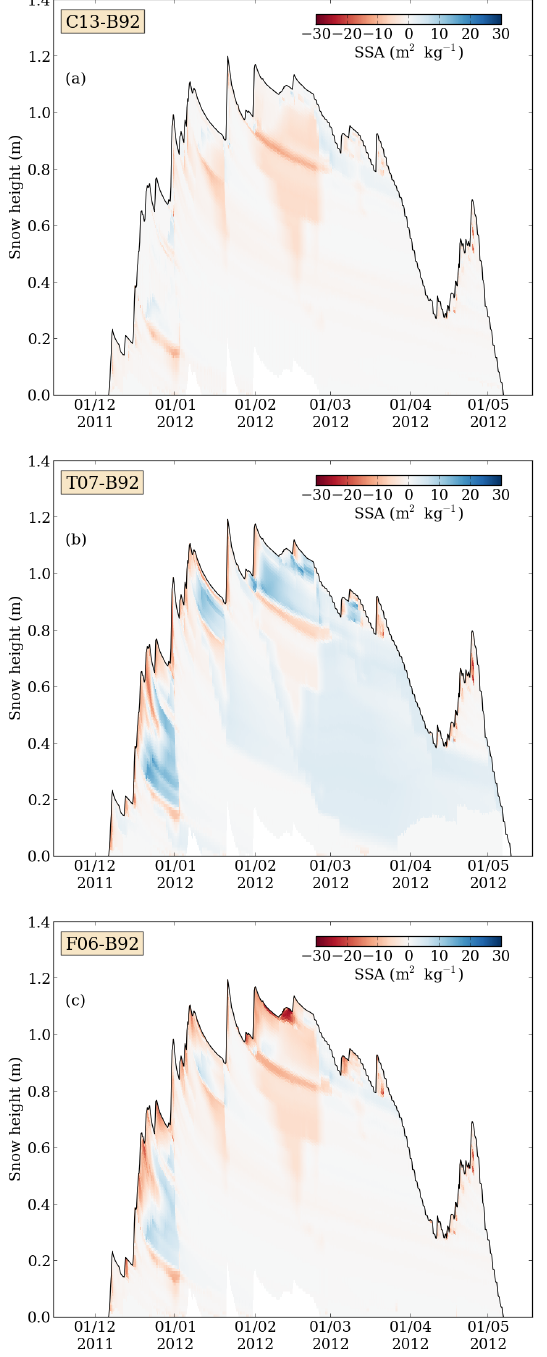
Fig. 12. Comparison in terms of SSA between the metamorphism formulations implemented in Crocus. In order to compare results obtained using different formulations, all SSA profiles were inter- polated over a 1cm vertical grid. The three plots show the differ- ence between the new formulations C13 (top), T07 (middle) and F06 (bottom) and the original formulation B92, for simulations run at Col de Porte during the winter of 2011/2012.